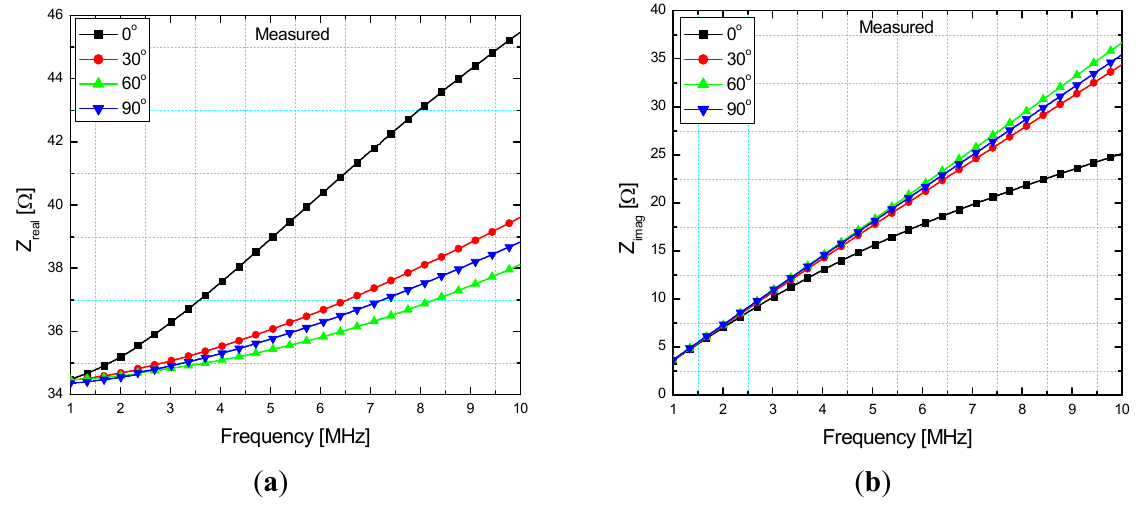
Figure 9. Measured ( a ) real part– Z with the short circuit at the rotor depending on frequency and angular position.